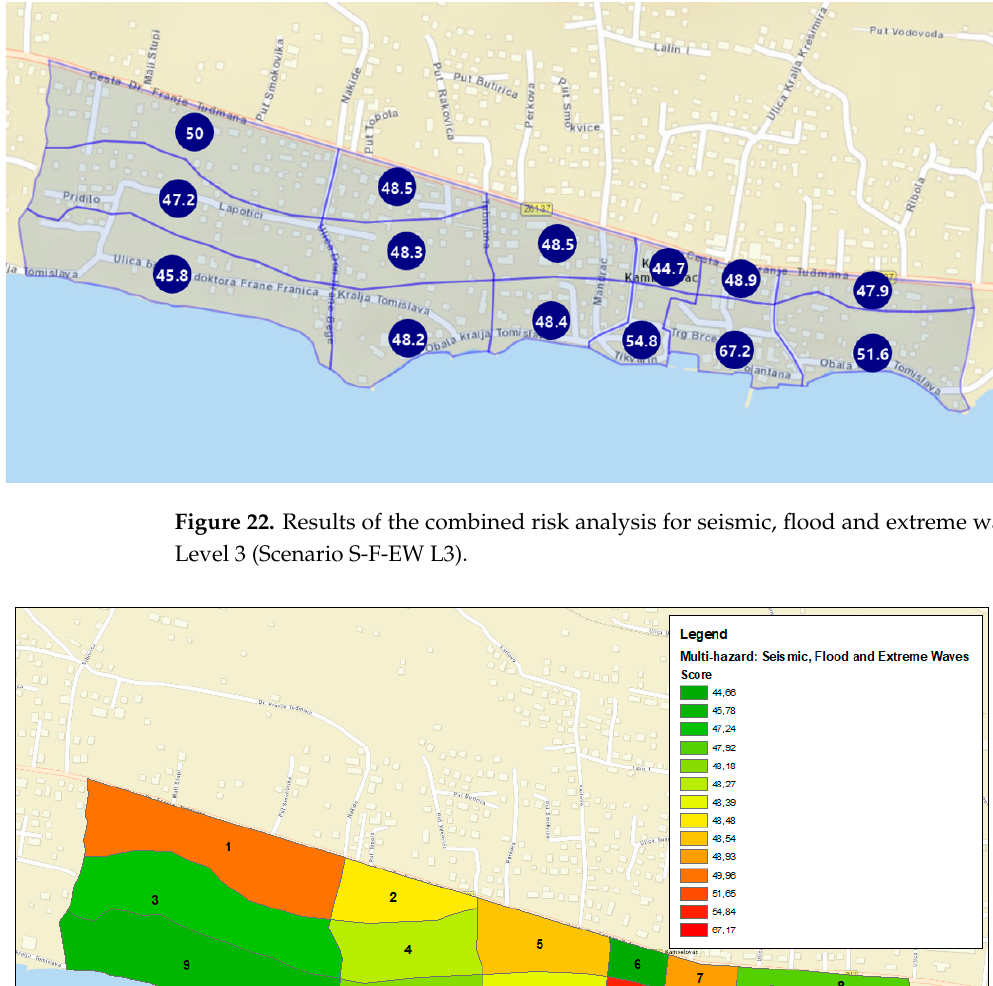
Figure 21. Results of the risk analysis for seismic, flood and extreme waves hazards for Level 2 (Scenario S-F-EW L2).